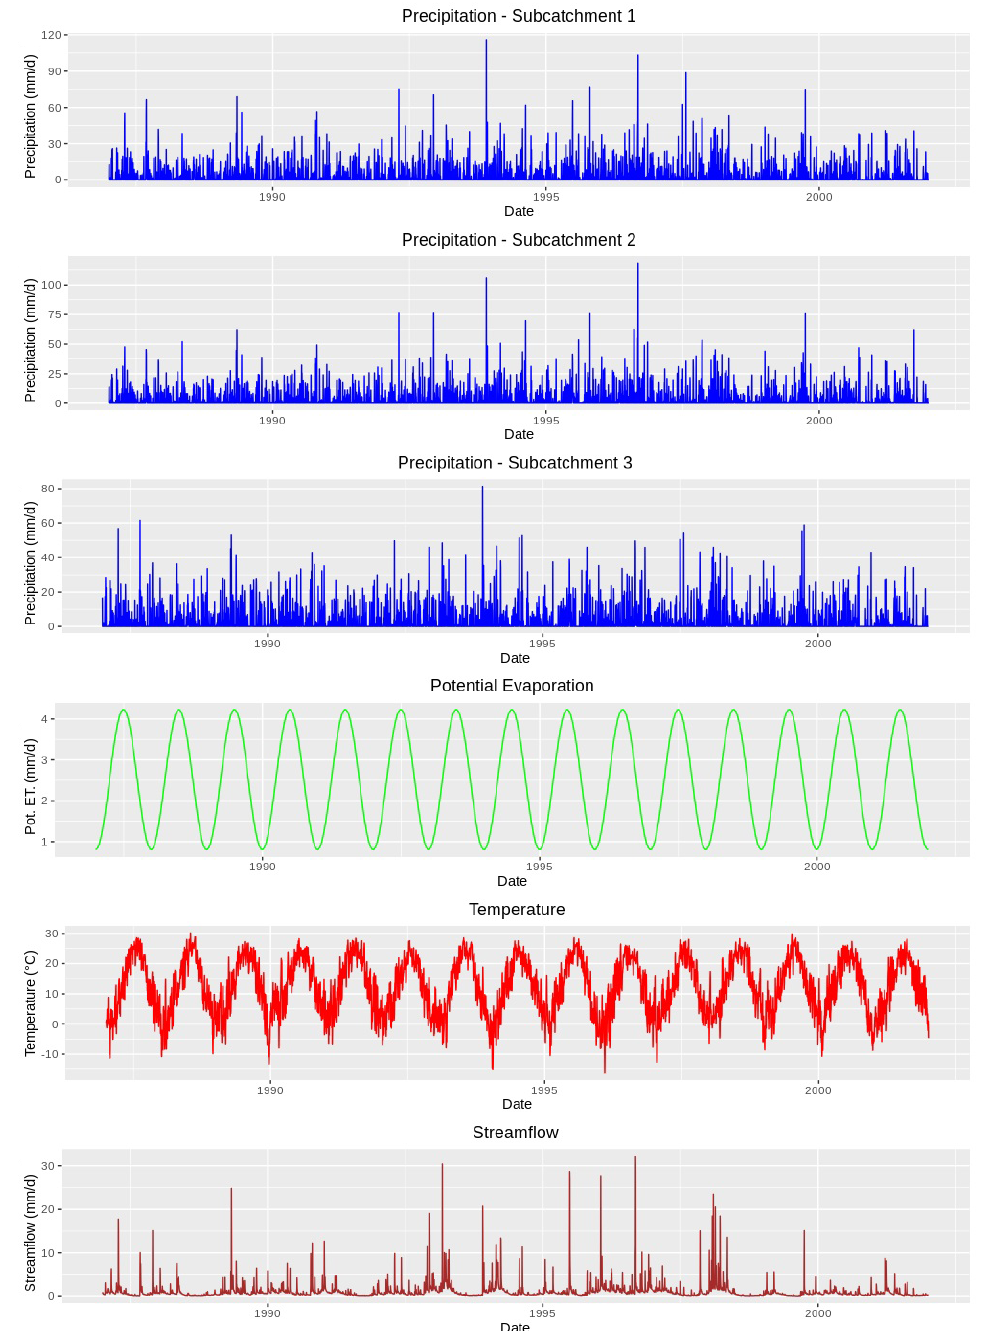
Figure 4. Forcing terms and streamflow data of Rappahannock River basin.